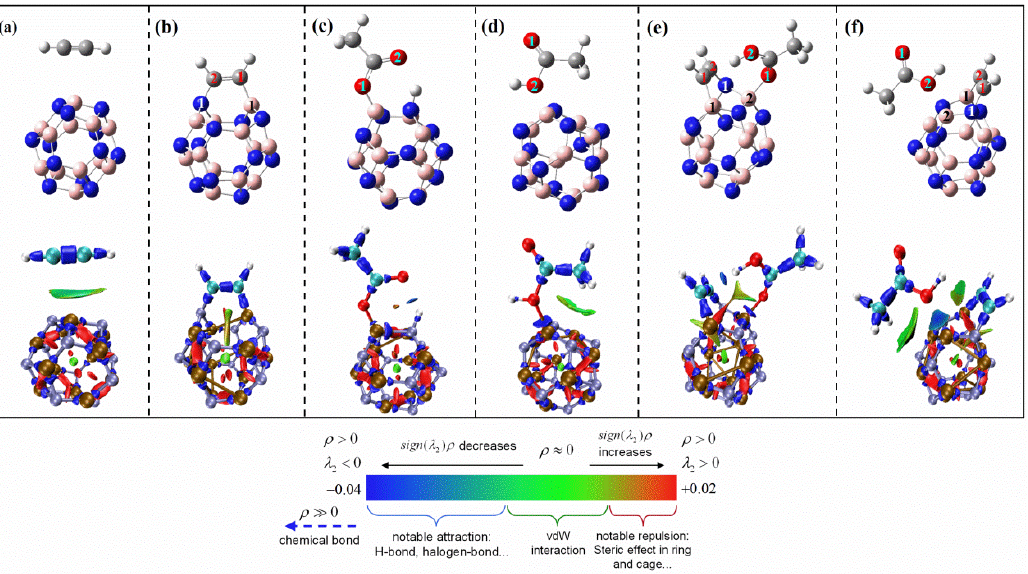
Figure 5. Optimized adsorption structures of C 2 H 2 and CH 3 COOH molecules on B 12 N 12 nanocages and the corresponding interaction region indicator (IRI) analysis (( a , b ) are the single adsorption structures of C 2 H 2 on BNNC, respectively; ( c , d ) are the single adsorption structures of CH 3 COOH on BNNC, respectively; ( e , f ) are the co-adsorption structures of C 2 H 2 and CH 3 COOH on BNNC, respectively).